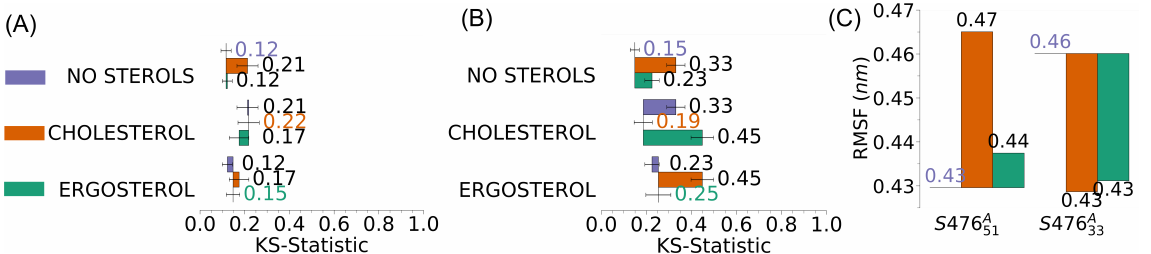
Figure 5. Difference in the spectra due to the presence of sterols in S. aureus membranes. Plots show the results of two-sample Kolmogorov-Smirnov (KS) tests for the average spectra of ( A ) S476 A and ( B ) S476 A , without any additional sterol, and with 1.3% cholesterol or ergosterol. Error bars 33 represent the standard error of the mean. ( C ) Average mobility measured as root-mean-squared fluctuations (RMSF) of the positions of non-sterol atoms in S476 A sterols (baseline) and with cholesterol (orange) or ergosterol